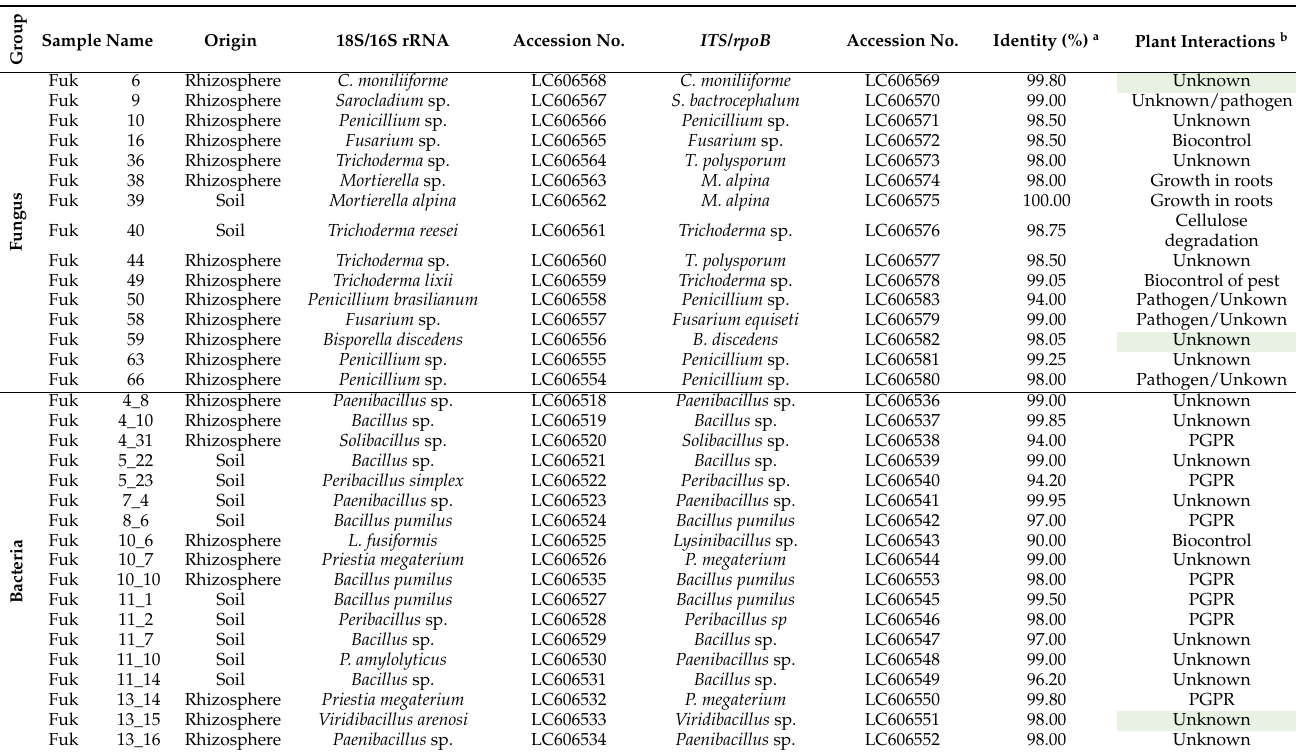
Table 1. Summary of the phylogenetic results of Fukushima